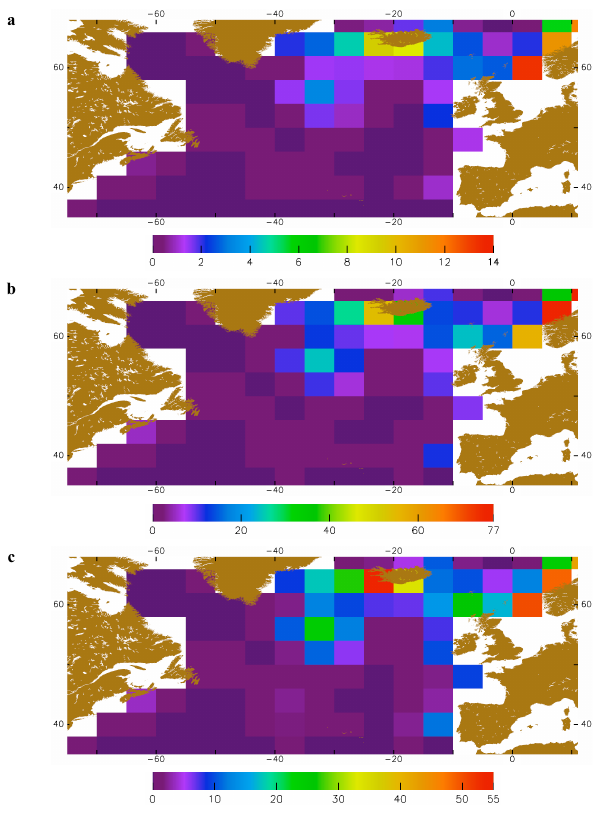
Fig. 4. Spatial distribution of the maximum impact of Emiliania huxleyi on the monthly air-sea CO 2 flux for years 1998–2007. (a) Percentage increase in seawater partial pressure p CO 2 (0–35%); (b) Percentage decrease in air-water partial pressure difference 1p CO 2 (0-231%); (c) Percentage decrease in air-sea CO 2 flux (0–